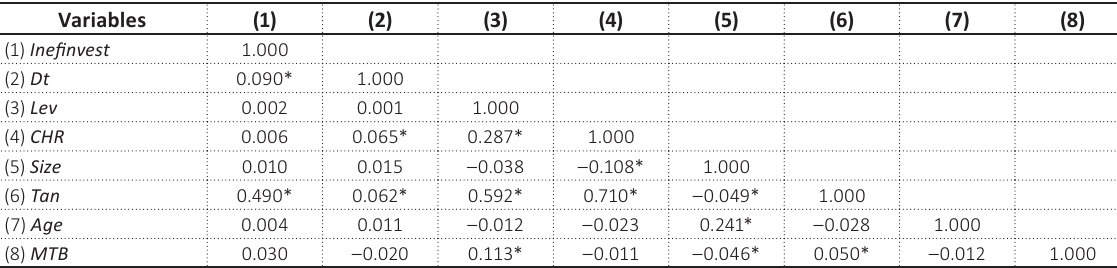
Table 2. Pairwise correlation matrix